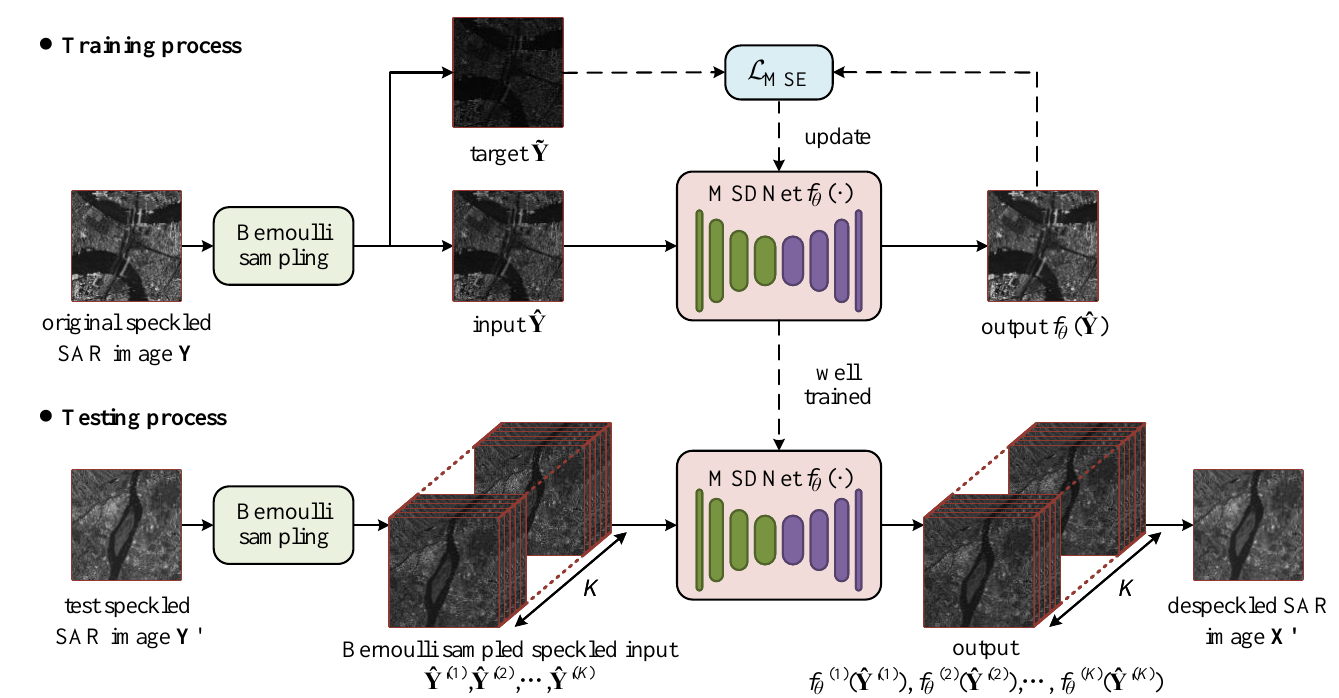
Figure 2. Overall flowchart of our proposed